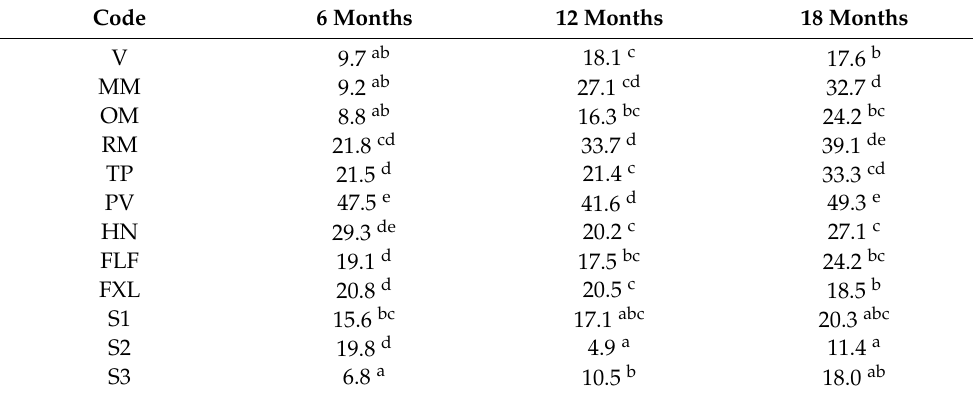
Table 7. Games–Howell pairwise mean differences of color change for Douglas-fir for each interval of the study. Letters in superscripts indicate which means between treatment groups that are not significantly different at the p < 0.05